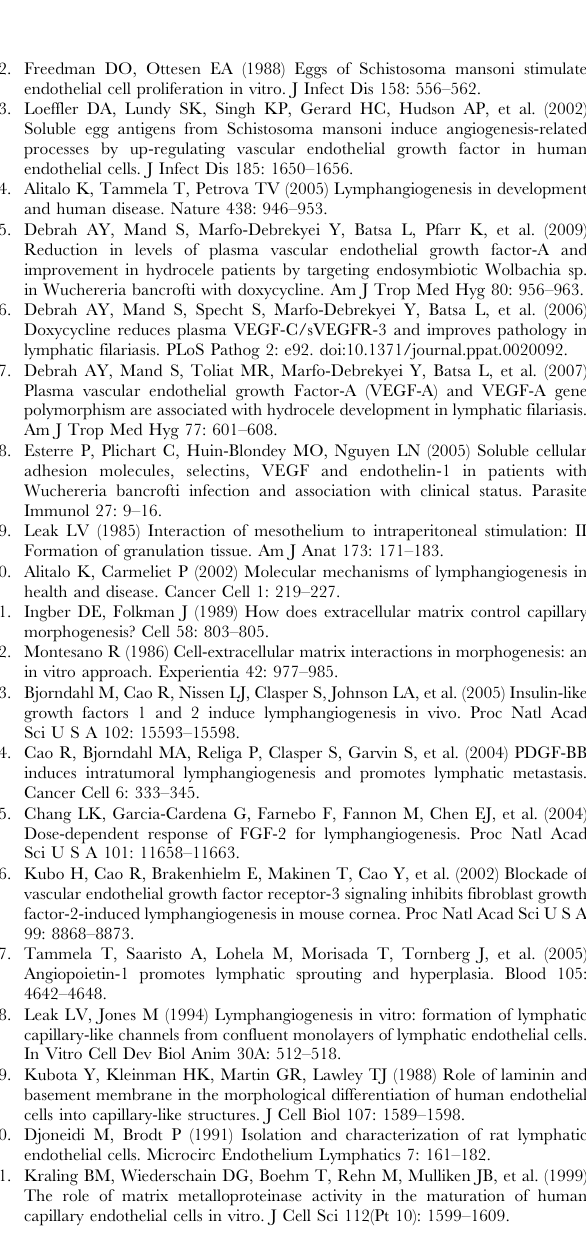
Figure S1 Characterization of LEC. LEC were analyzed for expression of lymphatic specific markers (A) podoplanin, (B) VEGFR3, (C) LYVE 1 and for absence of BEC markers (D) CD44 and (E) ICAM. LEC were . 98% podoplanin positive and negative for CD44 and ICAM (F and G). The isotype controls are solid peaks (A E). (H-K) Confocal images of LEC showing podoplanin (Alexa Fluor 488) (H), LYVE 1 (Alexa Fluor 594) (I), co localization of podoplanin and LYVE 1 (J), and DIC image of the LEC (K). (L) QRT-PCR expression of LEC specific markers as fold change compared with HDMEC. Figure S2 Quantitative reverse transcriptase real-time PCR data correlates strongly with expression levels assessed by microarray. Shown is the relationship of individual gene expression (fold change over media) as assessed by microarray (y-axis) and qRT-